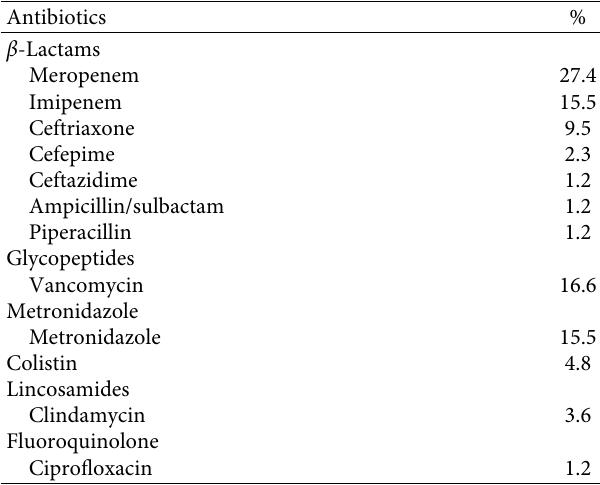
Table 2: Percentage of antibiotic classes used for treatment in 2–8 weeks prior sampling.